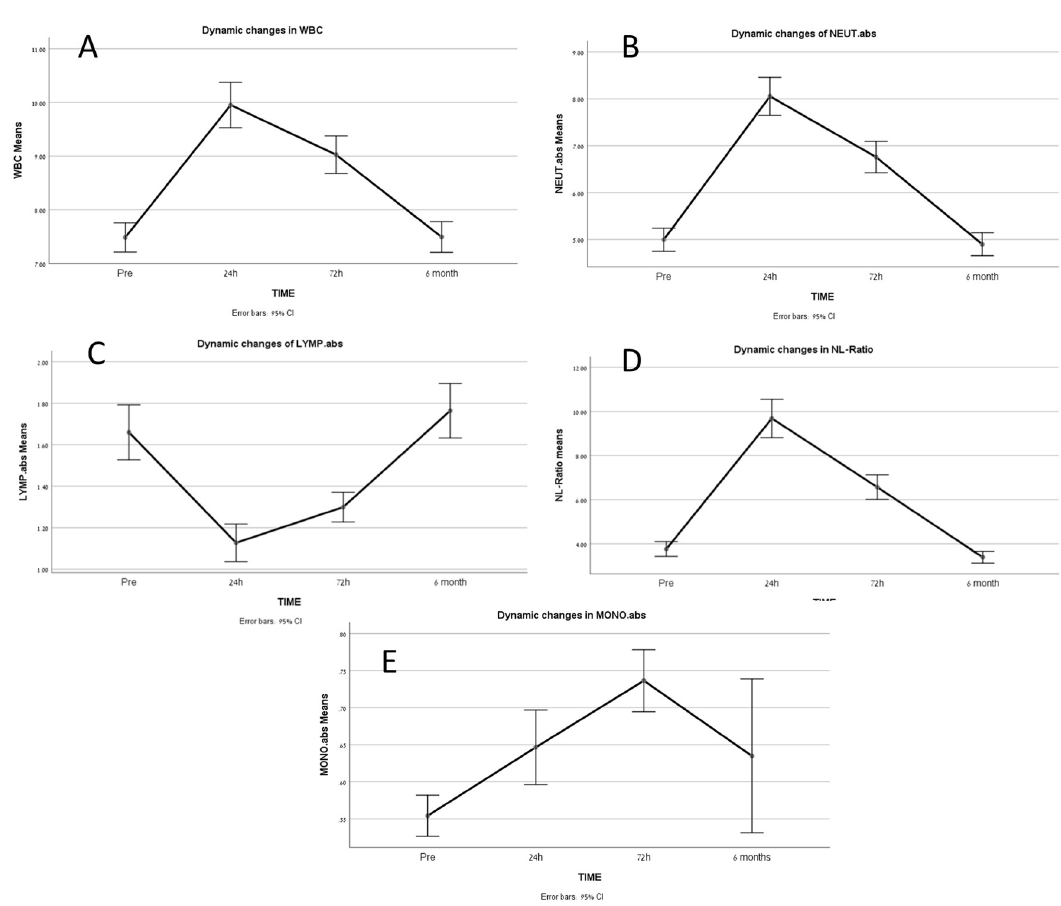
Fig 2. Dynamic changes of leukocytes and its components after TAVI, (A) dynamic changes in total WBC with time, (B) dynamic changes in Neutrophils with time, (C) dynamic changes of lymphocytes with time, (D) dynamic changes of NL ratio with time, (E) dynamic changes of monocytes with time. LYMP. abs = Absolute Lymphocytes (K/uL); NEUT. abs = Absolute Neutrophils (K/uL); MONO. abs = Absolute monocytes (K/uL); WBC = White Blood Cells (K/uL); NLR = Neutrophils to Lymphocytes